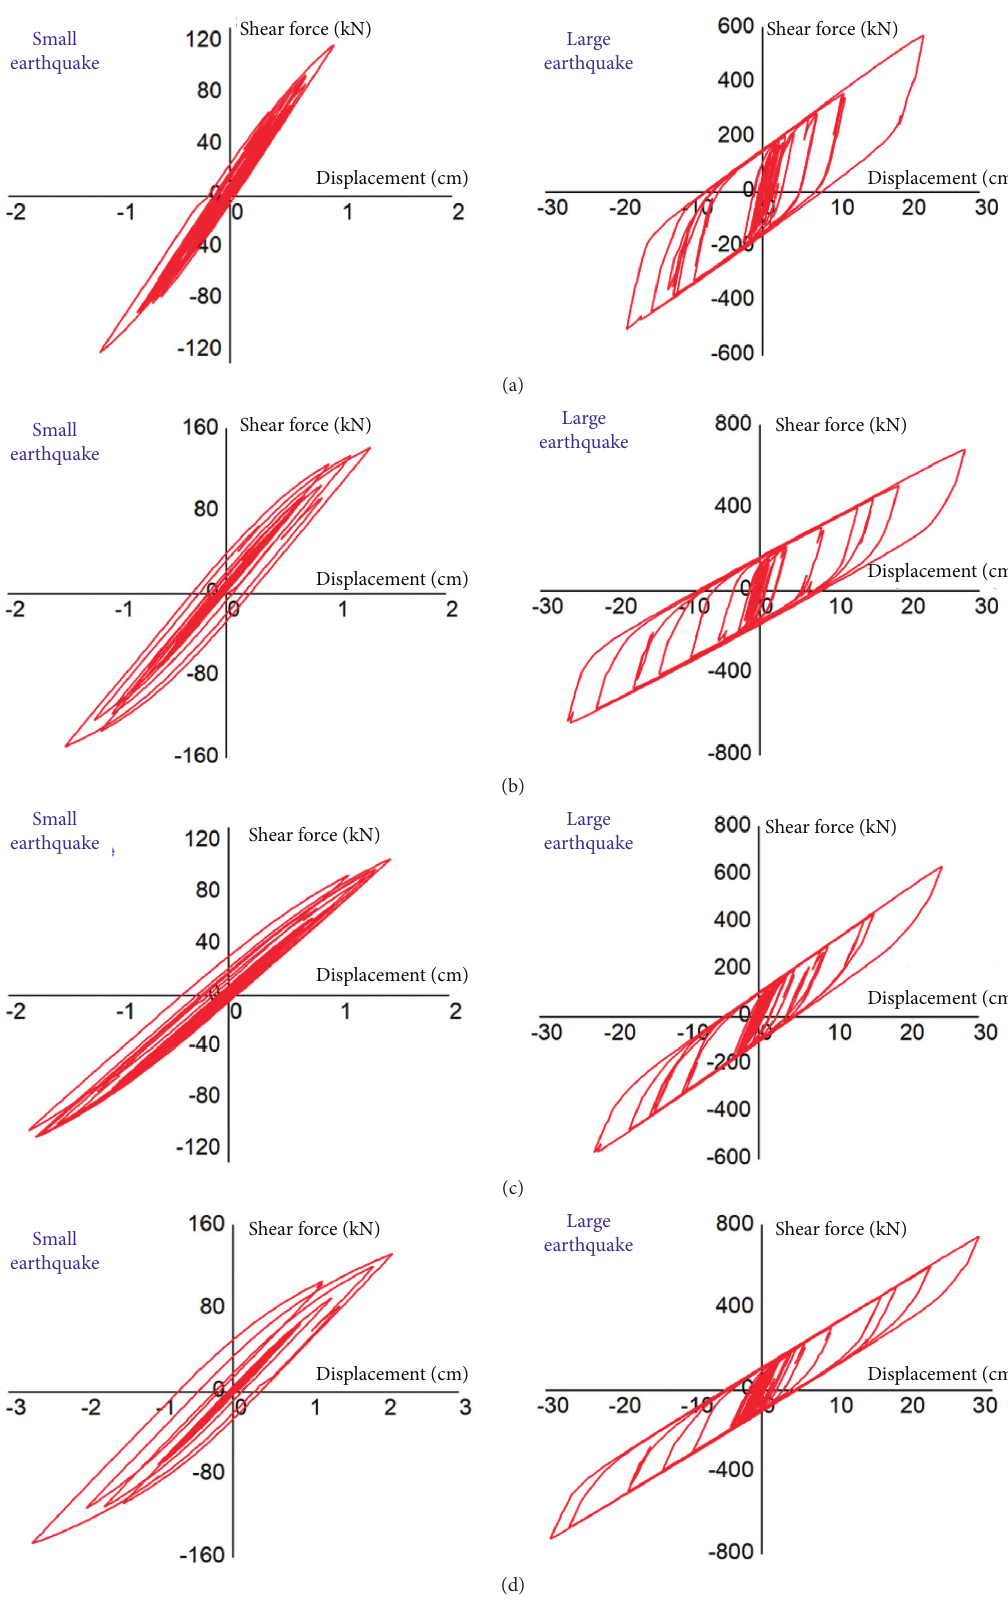
Figure 9: Hysteresis curve of bearings of the No. 2 pier: (a) LRB-2 in Case 3; (b) LRB-2 in Case 4; (c) HDRB-2 in Case 5; (d) HDRB-2 in Case